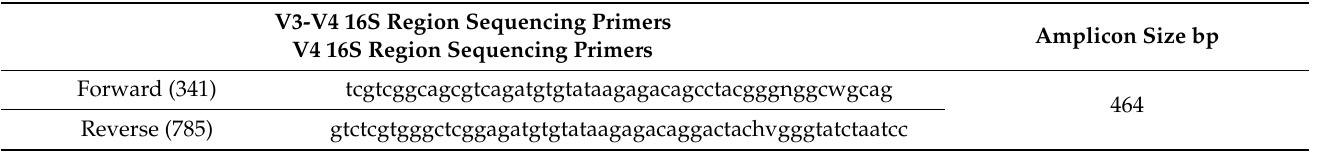
Table 3. DNA primers used in this study for the metagenome